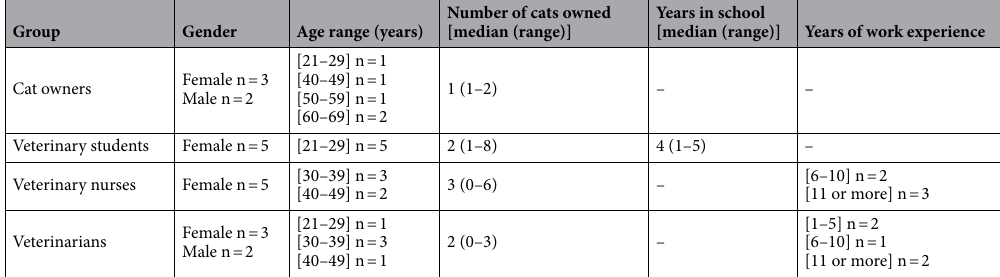
Table 1. Demographic information of the included participants in a study involving the Feline Grimace Scale via image assessment.